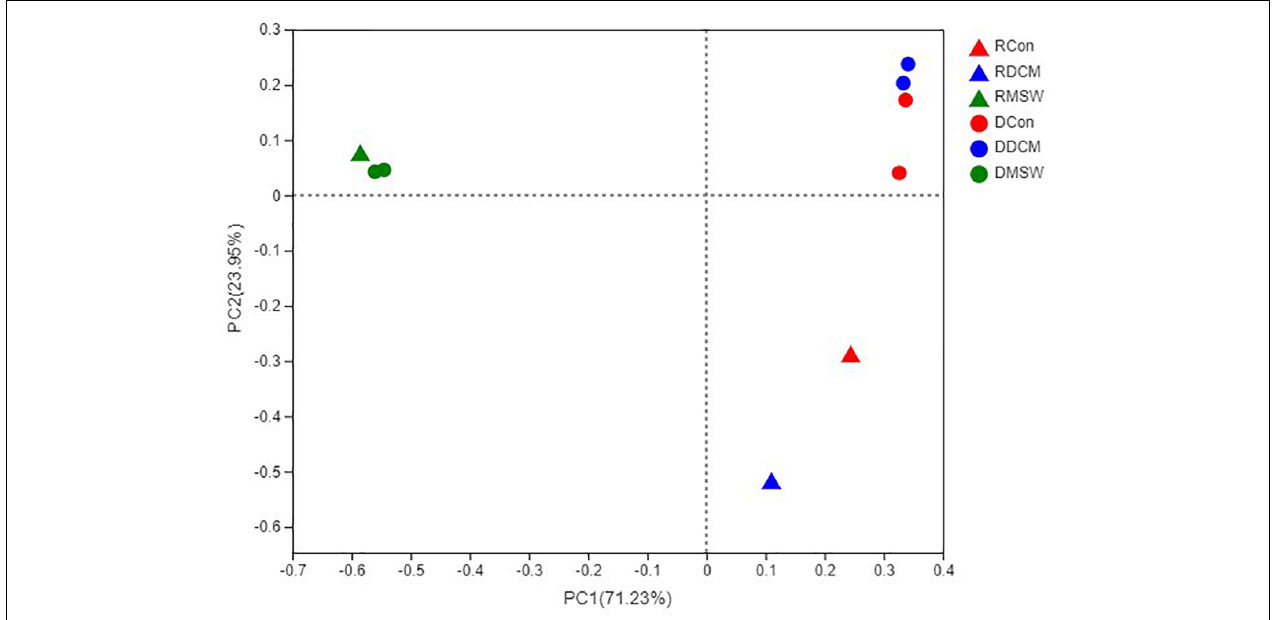
FIGURE 4 | Principal coordinates analysis (PCoA) based on a Bray–Curtis distance matrix representing differences in the community structure of six groups at the OTU level. The first and second principal components (PCo1 and PCo2) are shown, explained 71.23 and 23.95% of the variance in the dataset, respectively. Triangles and circles indicate control active (RNA) and total (DNA) archaeal communities, respectively. Con, DCM, and MSW groups are represented by red, blue and green, respectively.